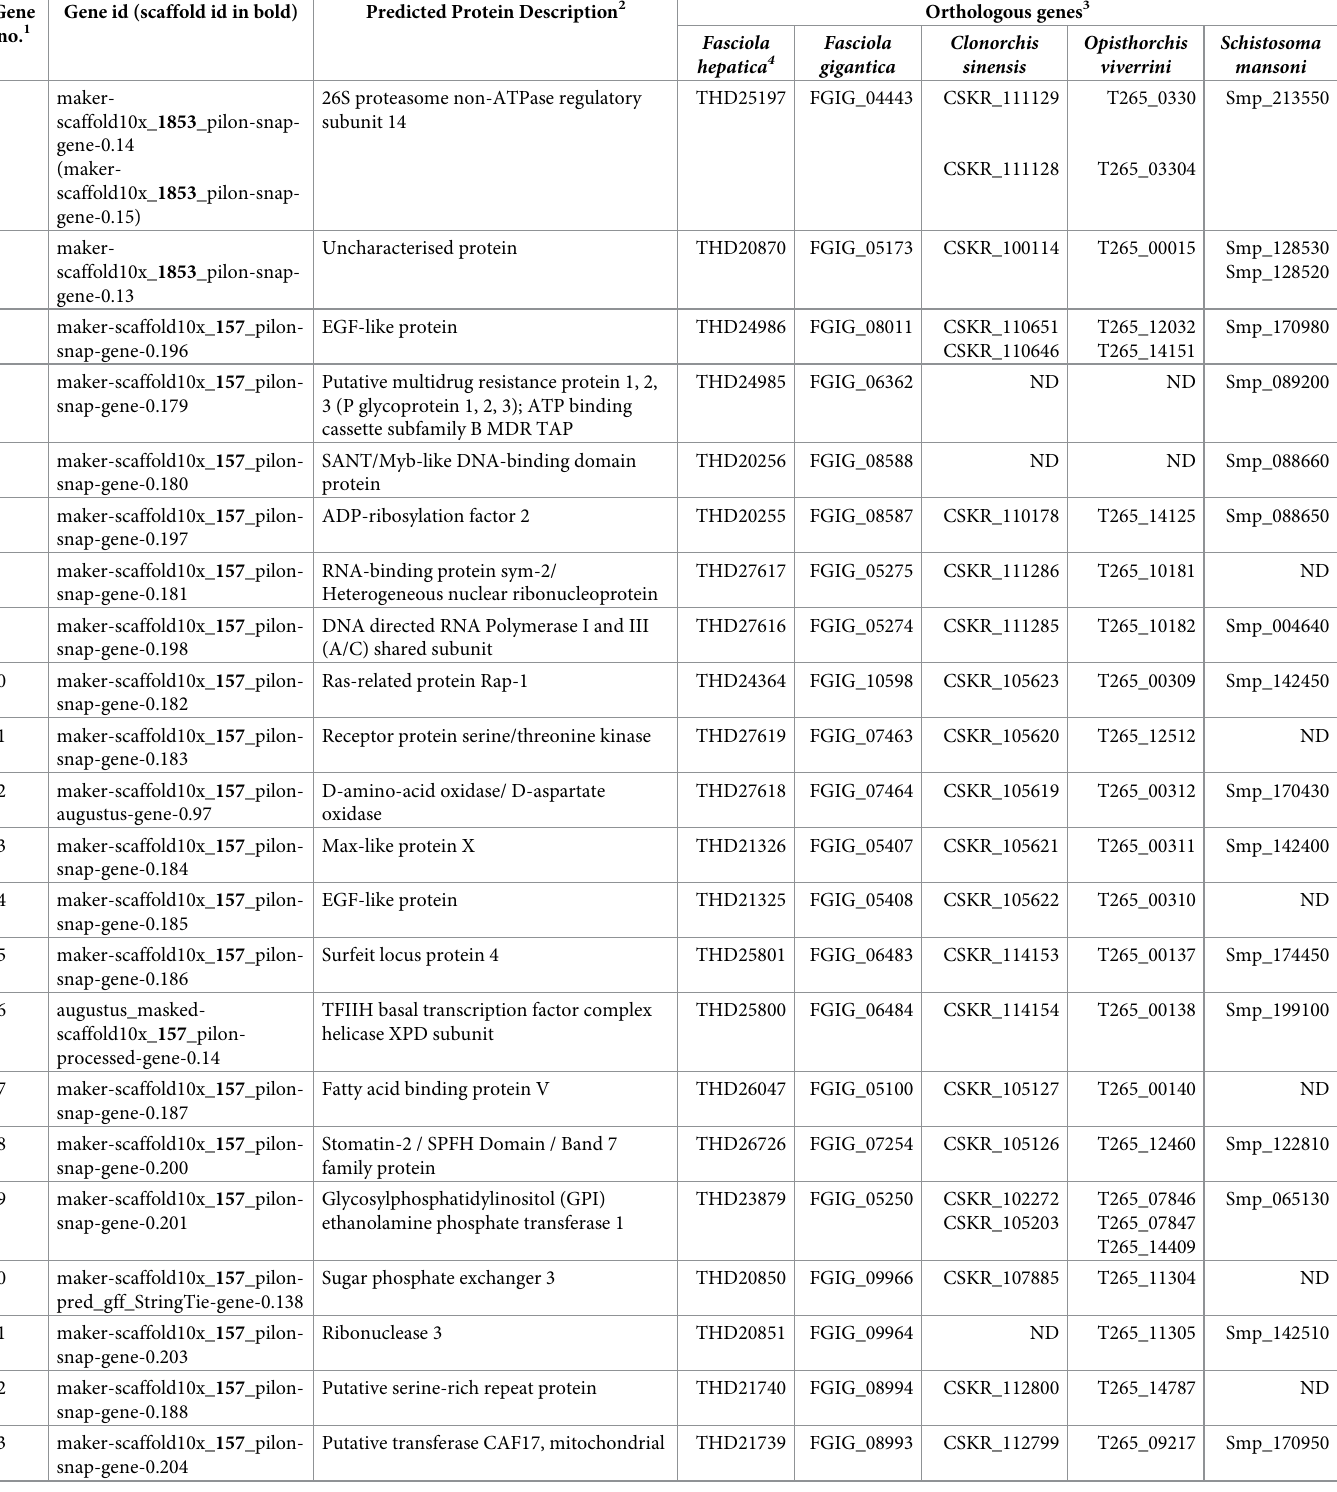
Table 5. Candidate genes identified following fine scale mapping of scaffolds under selection. Gene id (scaffold id in Gene no. 1